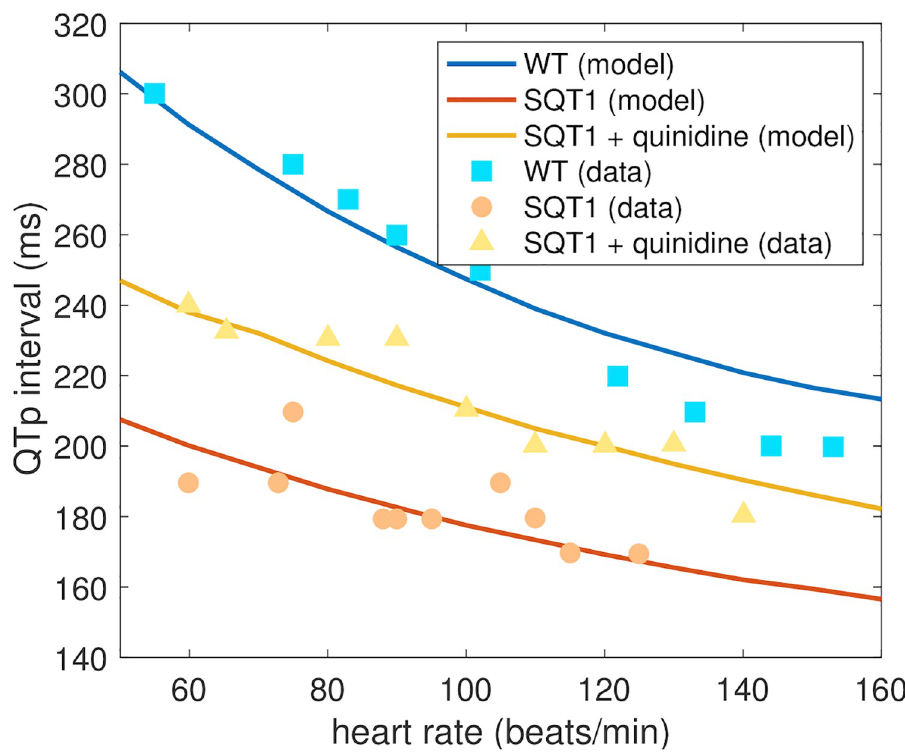
Fig 11. Comparison of measured and estimated adult QTp intervals. We compare the QTp intervals (see Fig 3) estimated by the computational procedure and the measured QTp intervals from [15] for different heart rates. We consider the WT case, the SQT1 case and the SQT1 case with cells exposed to 6.5 μ M quinidine. The drug effect estimated by the procedure is based on measured drug effects for SQT1 hiPSC-CMs from [9]. Data used in this figure can be found in S1